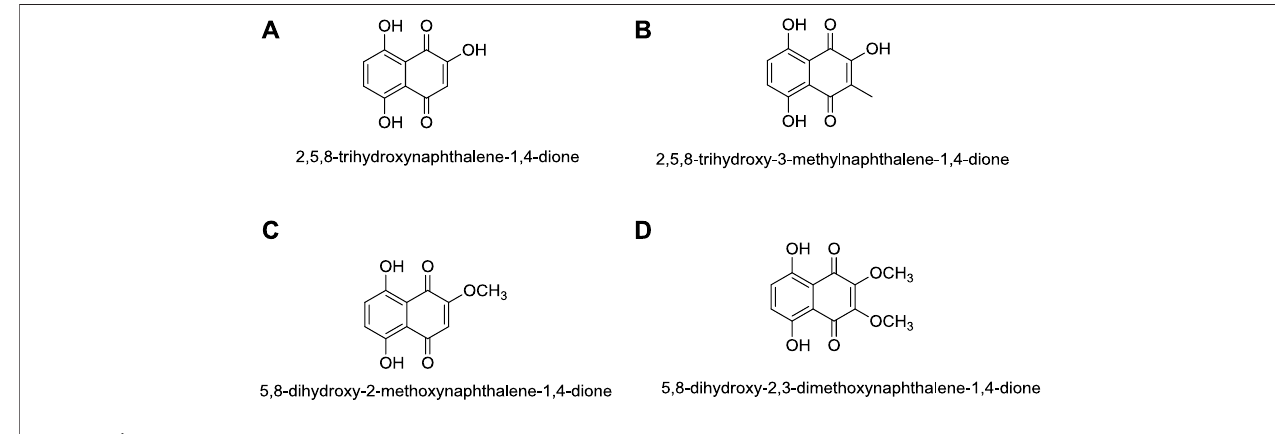
FIGURE 9 | Structure/Activity relationship of 1,4- naphthoquinone.